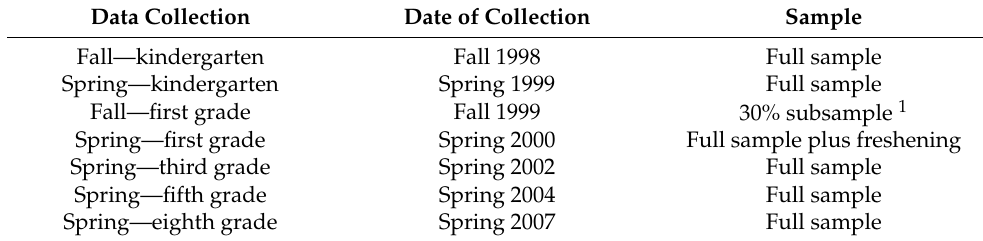
Table 1. ECLS-K waves of data